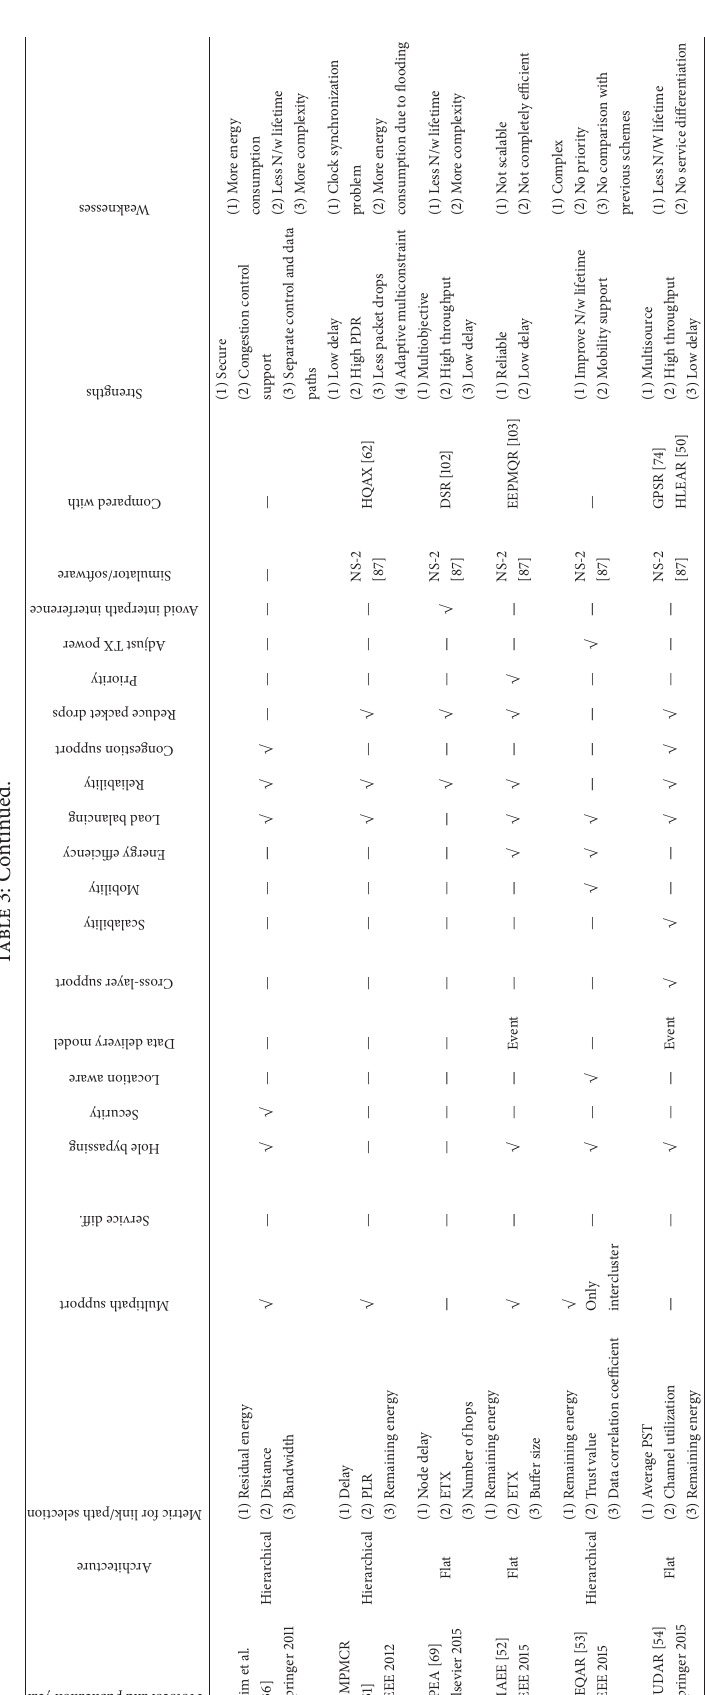
Protocolandpublicationyear